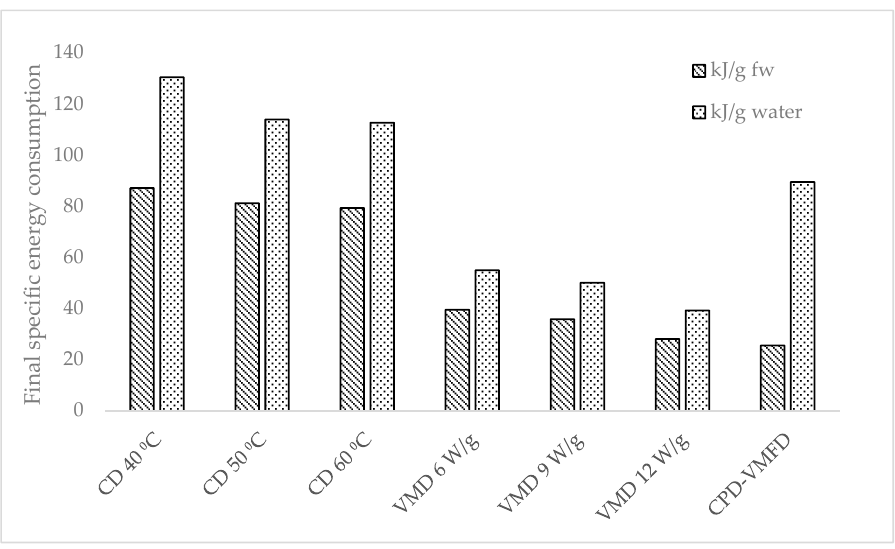
Figure 8. Specific energy consumption of S. crispus leaves per gram of water evaporated using CD, VMD, and CPD-VMFD. Molecules 2019 , 24 , x FOR PEER REVIEW